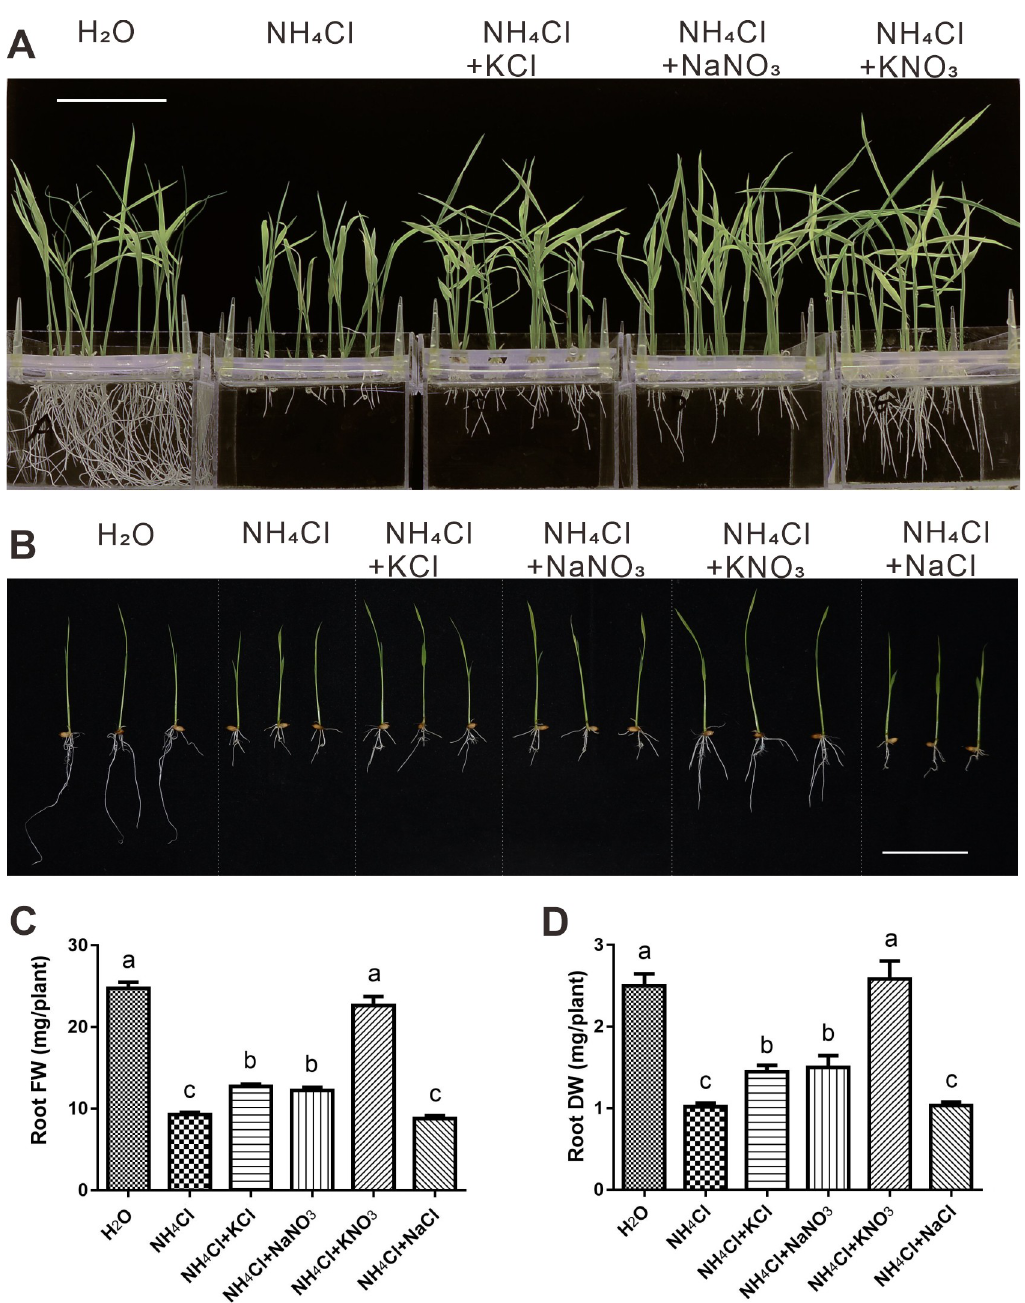
Fig 1. Phenotypes of rice seedling roots under. (A) Photograph of 10-day-old rice seedlings. (B) Photograph of 7-day-old rice seedlings. (C and D) Fresh weight (FW) and dry weight (DW) of roots of 7-day-old seedlings. Scale bars = 5 cm. Data are mean ± SD; t-tests were used to identify significant differences, and different letters represent significant differences among different treatments (p < 0.05).